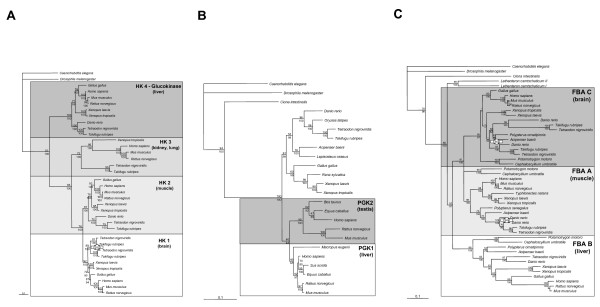
Maximum-likelihood trees of the monomeric glycolytic enzymes hexokinase (HK), phosphoglycerate kinase (PGK) and fructose-bisphosphate aldolase (FBA) dataset comprising 44 amino-acid sequences for HK (909 AA), 15 amino-acid sequences for PGK (417 AA), and 47 amino-acid sequences for FBA (366 AA). Values at the branches are support values (ML bootstrapping/MB posterior probabilities). 'FSGD' depicts putative fish-specific gene duplication events.